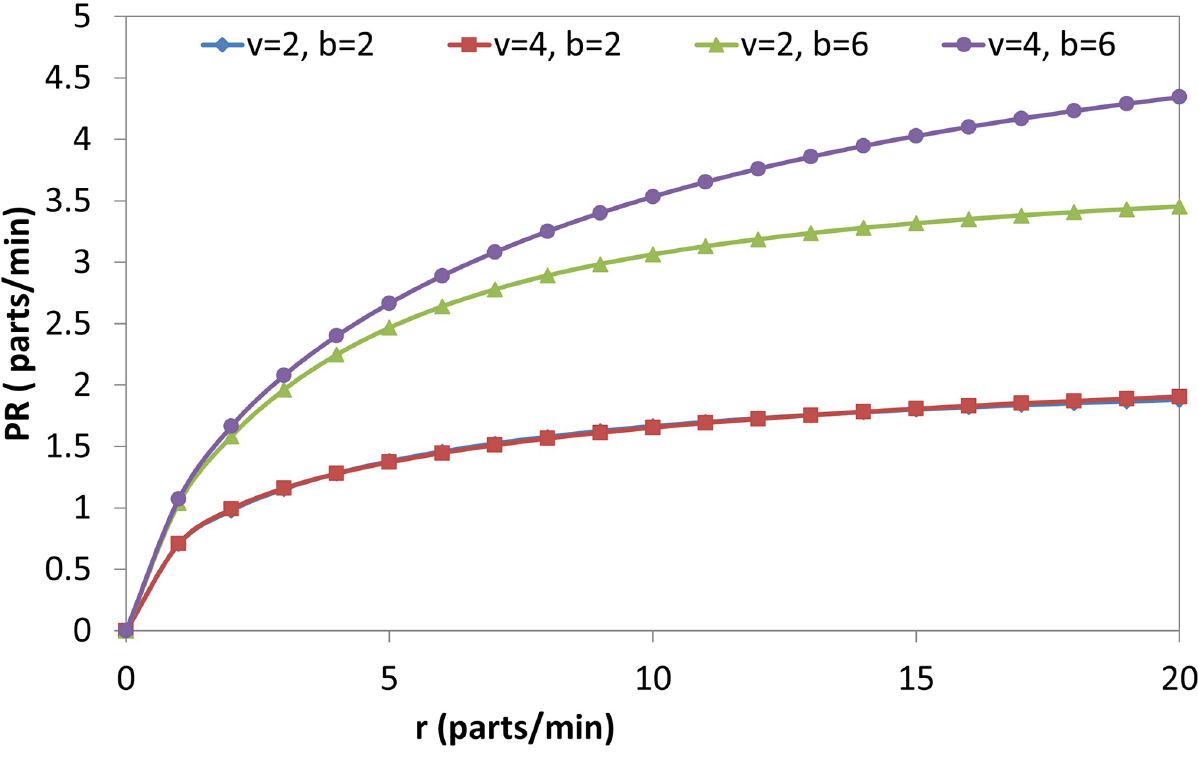
Fig 18. PR-r diagram for triple-machine FMC. https://doi.org/10.1371/journal.pone.0259247.g018 robot is R multiplied by the percentage of time the robot is working (PR/r). In contrast, the C(o) cost rate associated with the idle robot is R multiplied by the percentage of time the robot is C(i) idle (1-PR/r). Similarly, the cost rate associated with the processing machines is M multi- C(o) plied by the percentage of the total time that the machines are working (PR/vn). The cost rate associated with the idle machines is M multiplied by the percentage of the total time the C(i)